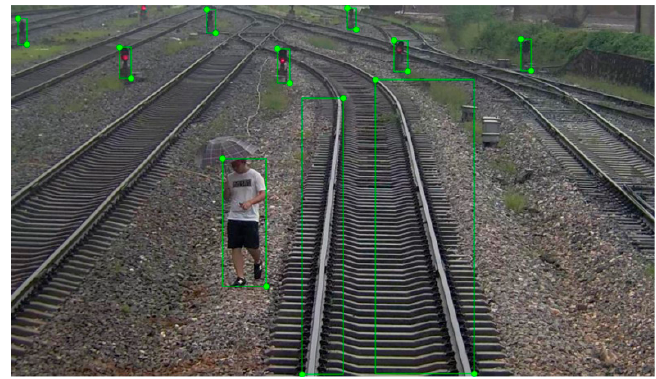
Figure 2. PEI contrast.